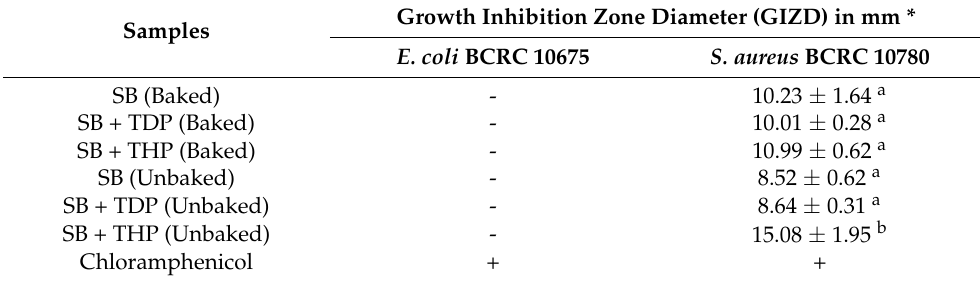
Table 7. Antibacterial activity of snack bar products.